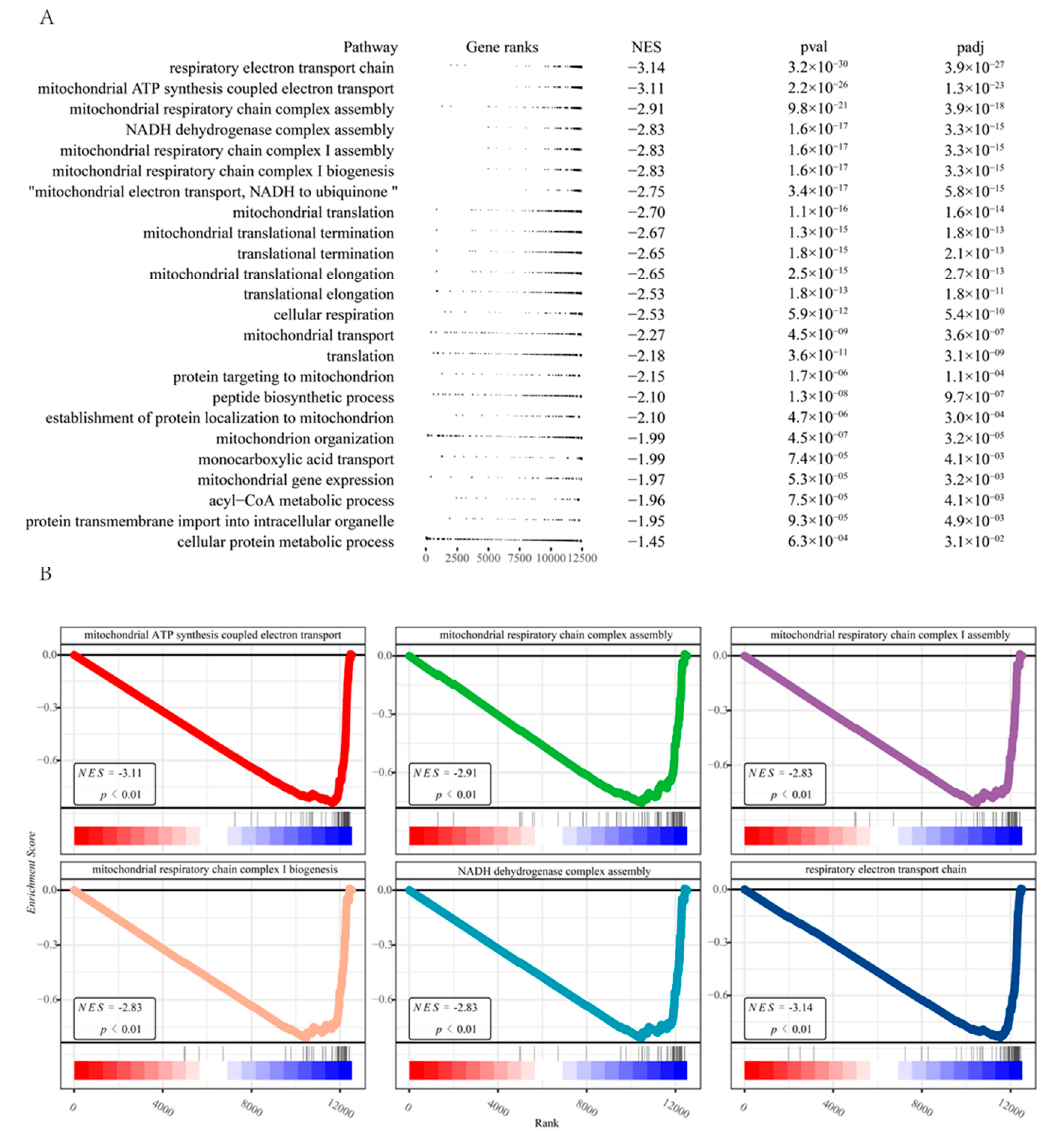
Figure 3. ( A ) A table plot for the ranked GSEA of the differential expression analysis results. ( B ) Enrichment plots of the six top pathways derived from the ranked GSEA.